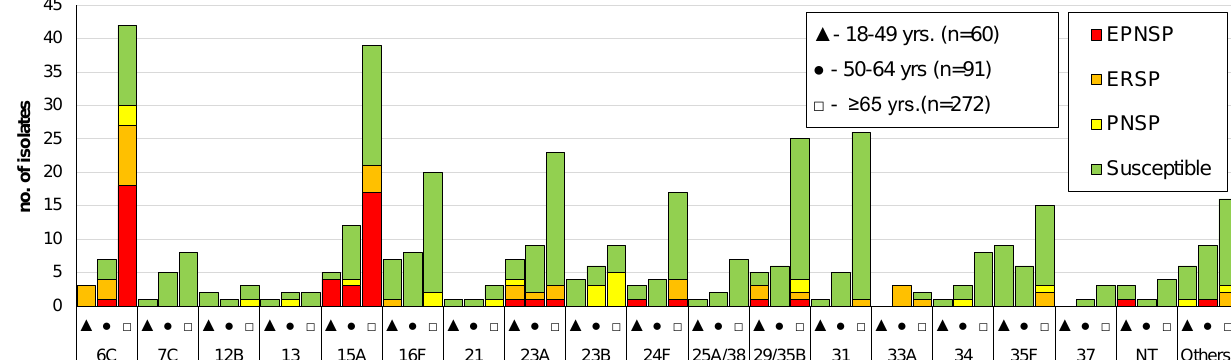
Figure 3. Isolates expressing serotypes not included in any pneumococcal vaccine causing invasive pneumococcal disease in adult patients (≥18 years) in Portugal from 2015 to 2018. See legend of Figure 1. NT: non-typable. Isolates expressing serotypes 25A/38 and 29/35B could not be phenotypically distinguished and are represented together. Only serotypes including n > 3 isolates were discriminated. Others include the following serotypes: 9A, 11D ( n = 3 each); 6D, 11F, 11C, 12A, 15F, 18A, 22A, and 35A ( n = 2 each); and 7B, 19B, 19C, 24A, 24B, 28A, 39, and 43 ( n = 1 each).